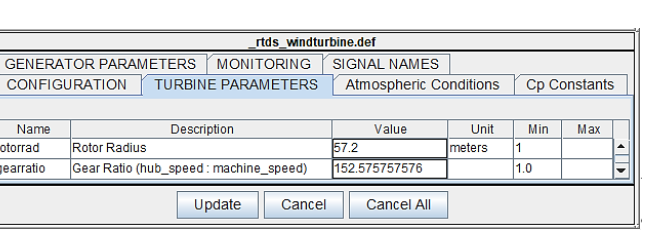
Figure 7. Wind turbine rotor radius and gearbox ratio parameter settings.